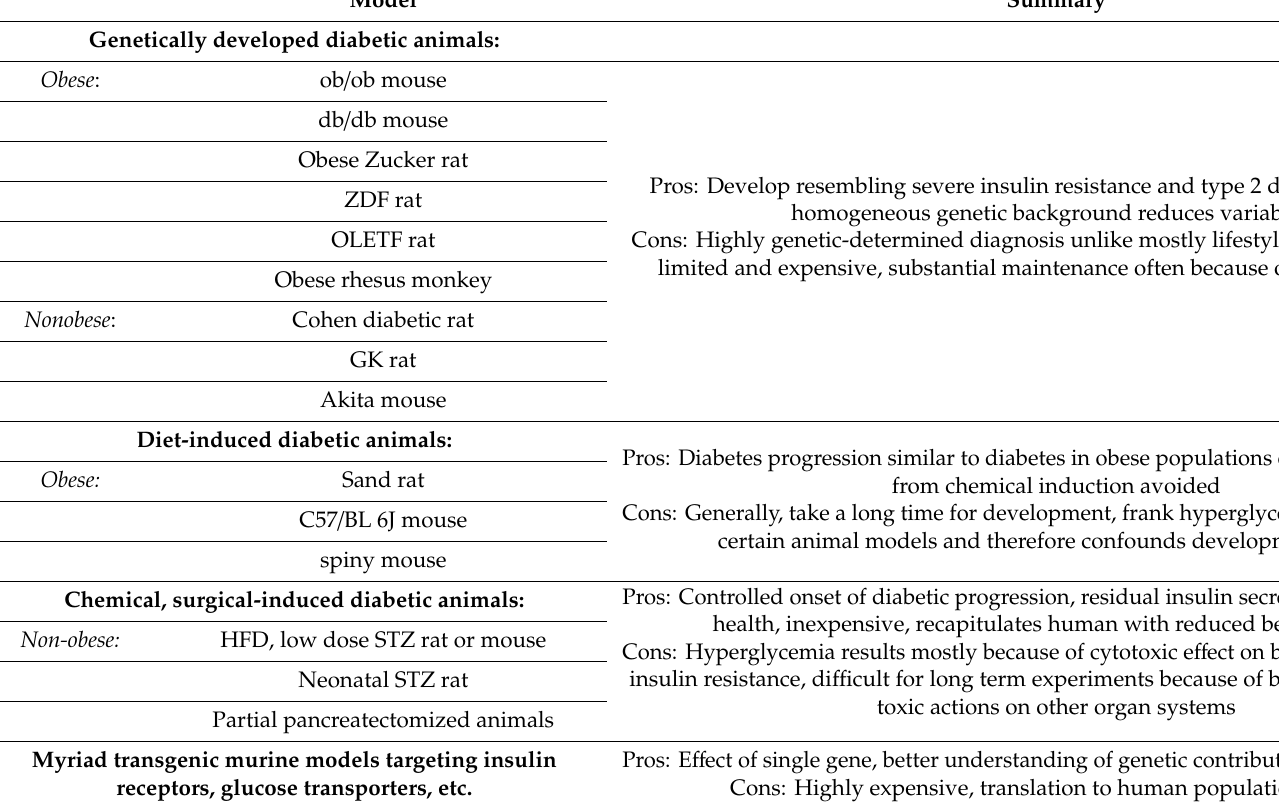
Table 2. Summary of diabetic animal models re-summarized from Srinivasan et al. 2007.